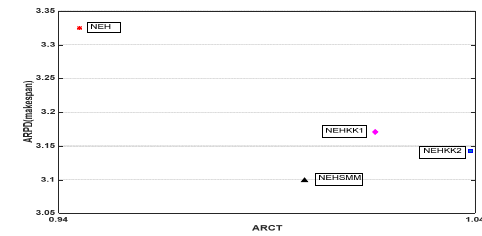
Fig. 2. ARPD vs ACPU on Taillard's benchmarks Fig. 3. ARPD vs ARCT on Taillard's benchmarks